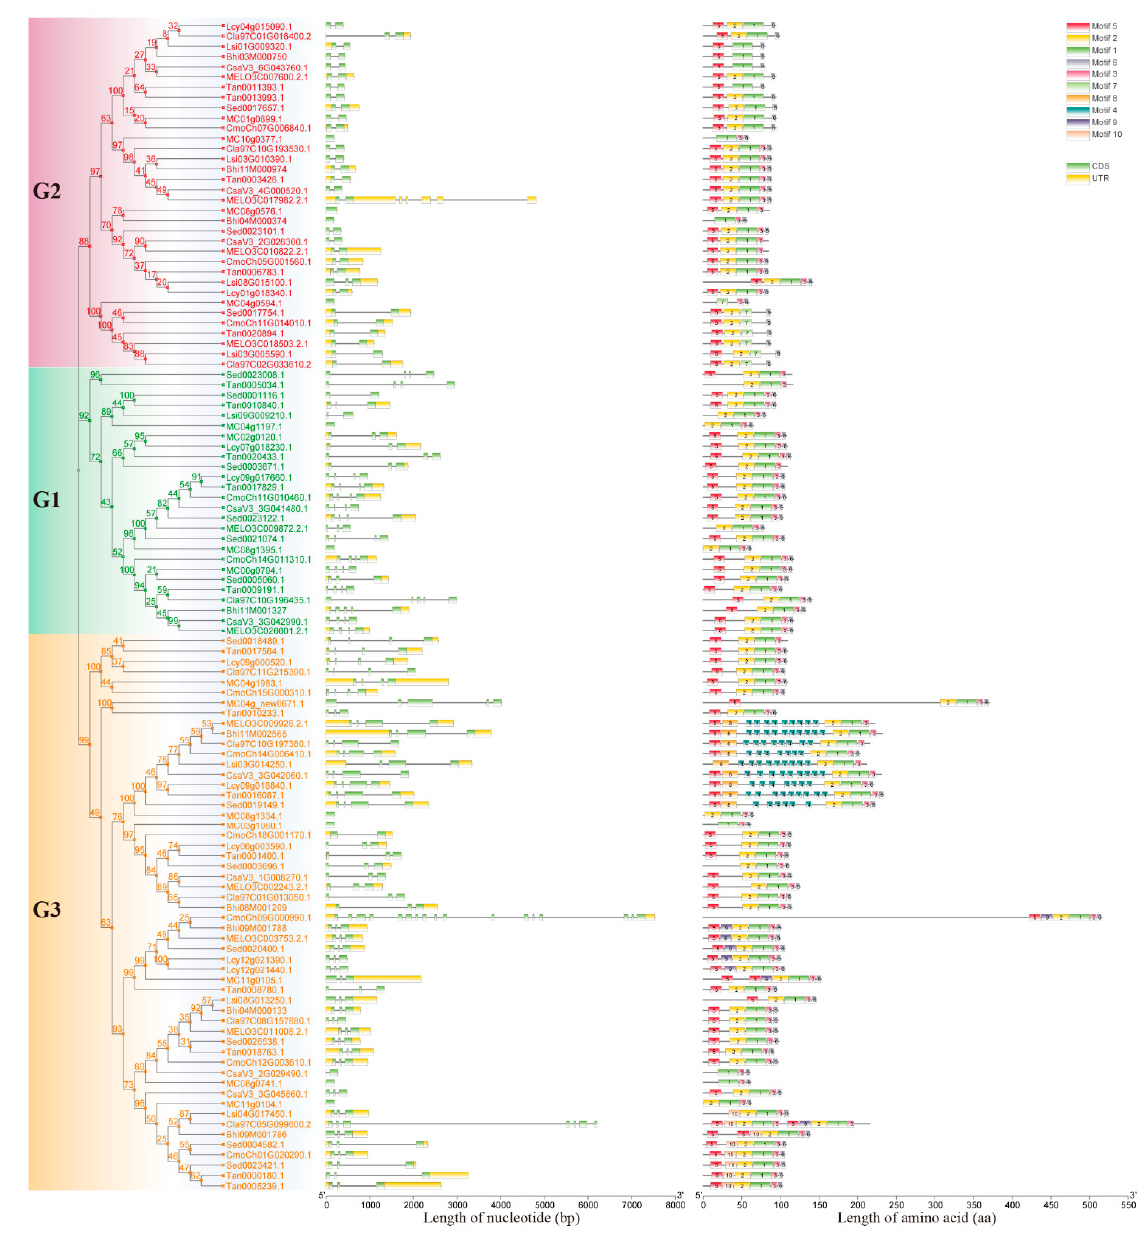
Figure 2. Exon-intron structures of GASA genes and a schematic diagram of the amino acid motifs of GASA proteins in 10 Cucurbitaceae species. Table 2. The motif information on GASA proteins in 10 Cucurbitaceae species.